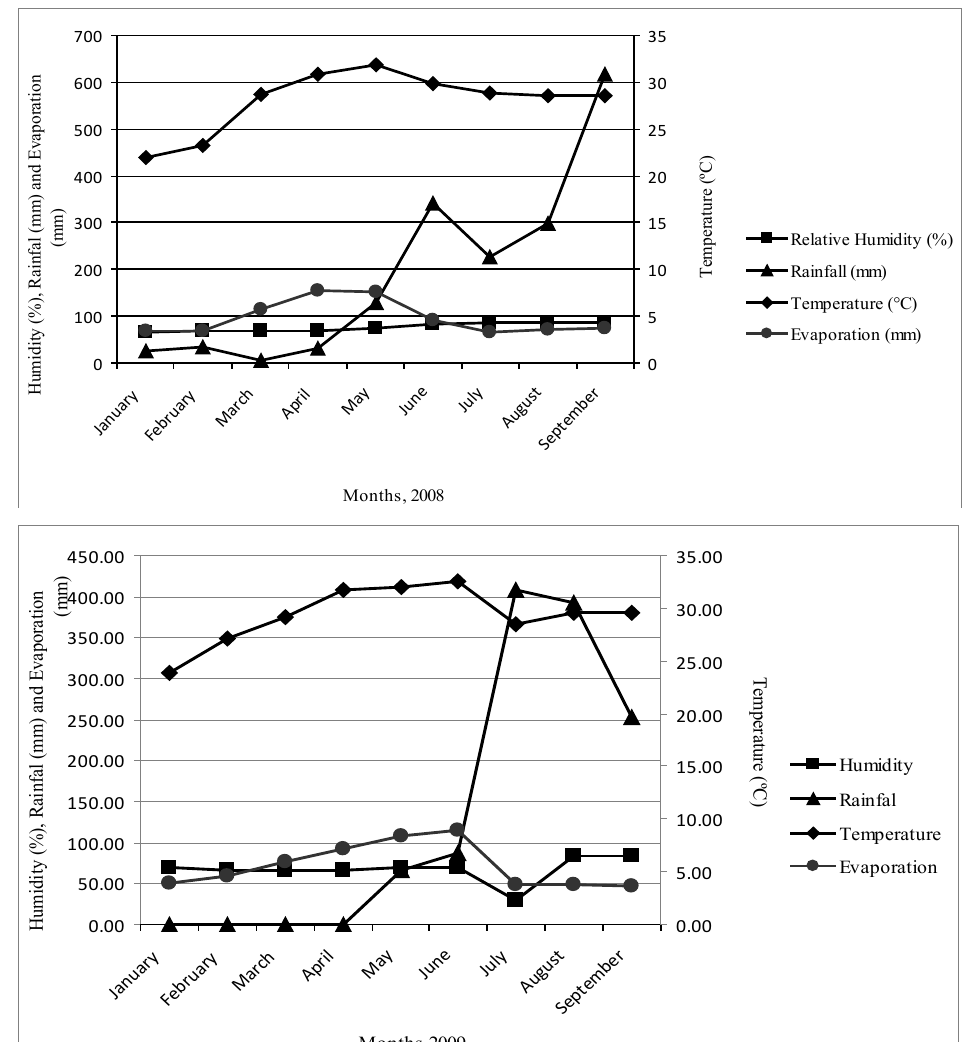
Fig. 1. Meteorological data of cropping years (Source: Department of Agricultural Meteorology, O.U.A.T.,